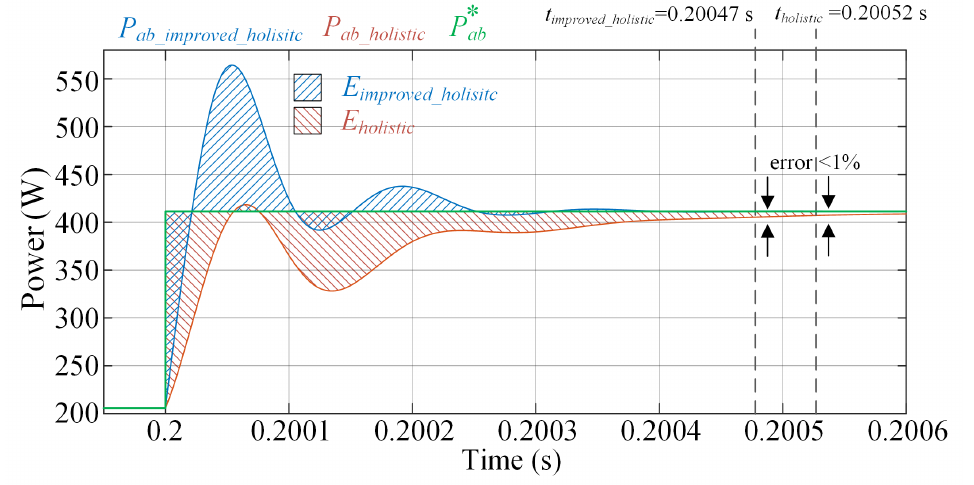
Figure 8. Load transient in ISM going from 205.7 W to 414.4